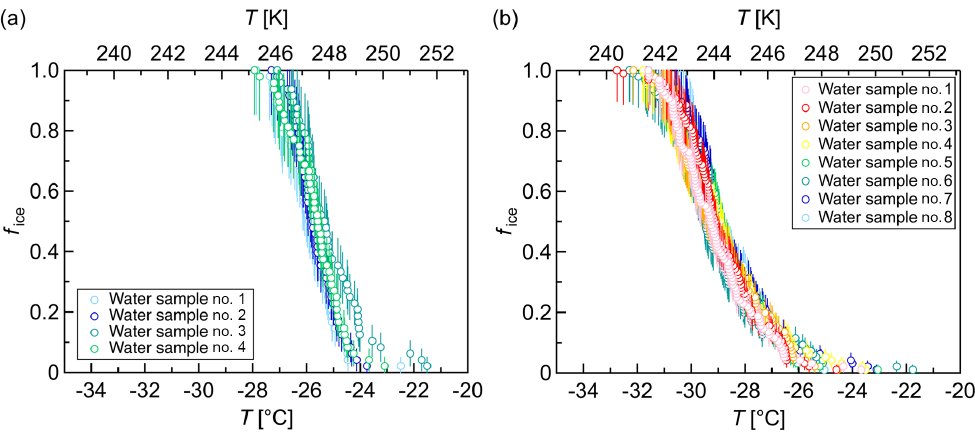
Figure 6. Freezing experiments with pure-water droplets. Fraction of frozen droplets ( f ice ) vs. temperature ( T ) obtained with a continuous cooling rate of 1Kmin − 1 and a droplet volume of 3µL. (a) Four different samples with 48 droplets each apportioned over two 96-well plates. (b) Eight different samples with 96 droplets each apportioned over two 384-well plates. The error bars were calculated using the counting error and the Gaussian error propagation. The temperature error is 0.2K.